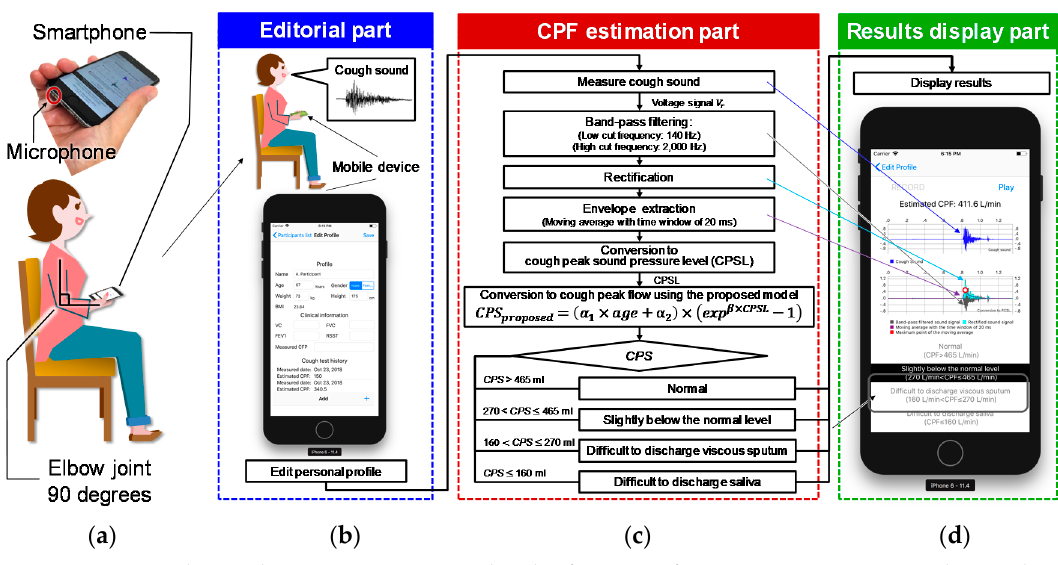
Figure 1. Cough sound measurement protocol and software configuration. CPS represents the cough peak flow estimated using cough sounds. ( a ) The posture of a user while recording cough sounds.